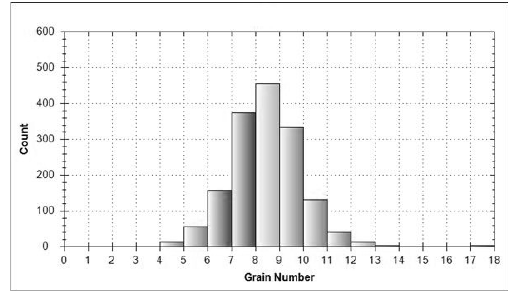
Figure 11. Grain size distribution for the austenitizing temperature of 1000°C.